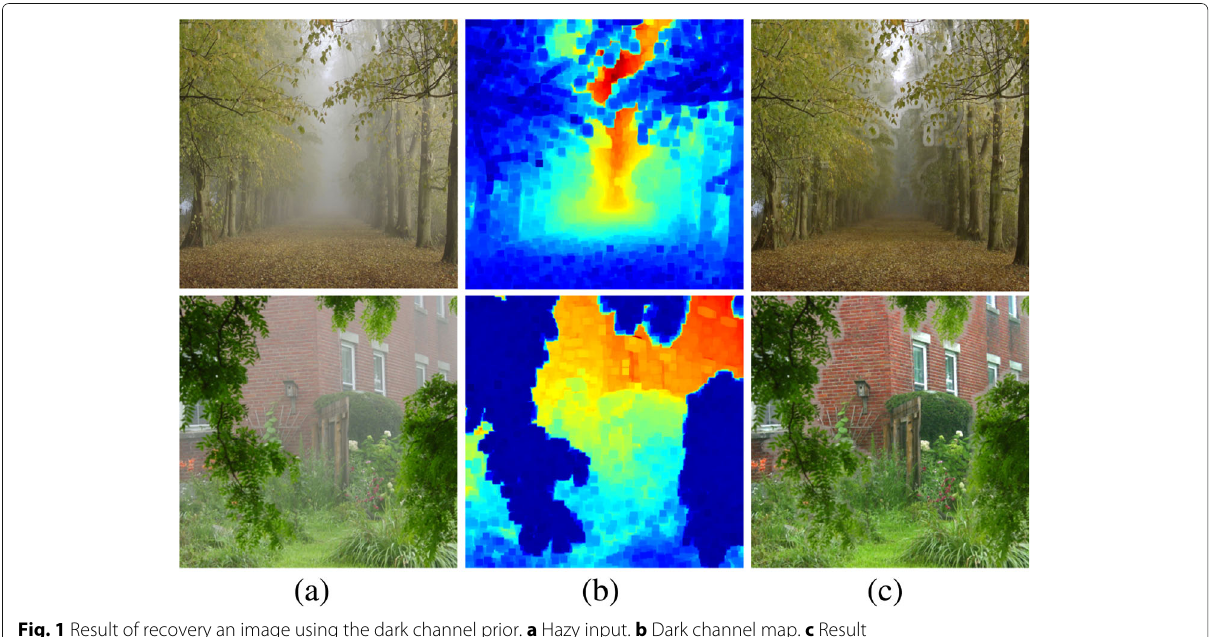
Fig. 1 Result of recovery an image using the dark channel prior. a Hazy input. b Dark channel map. c Result